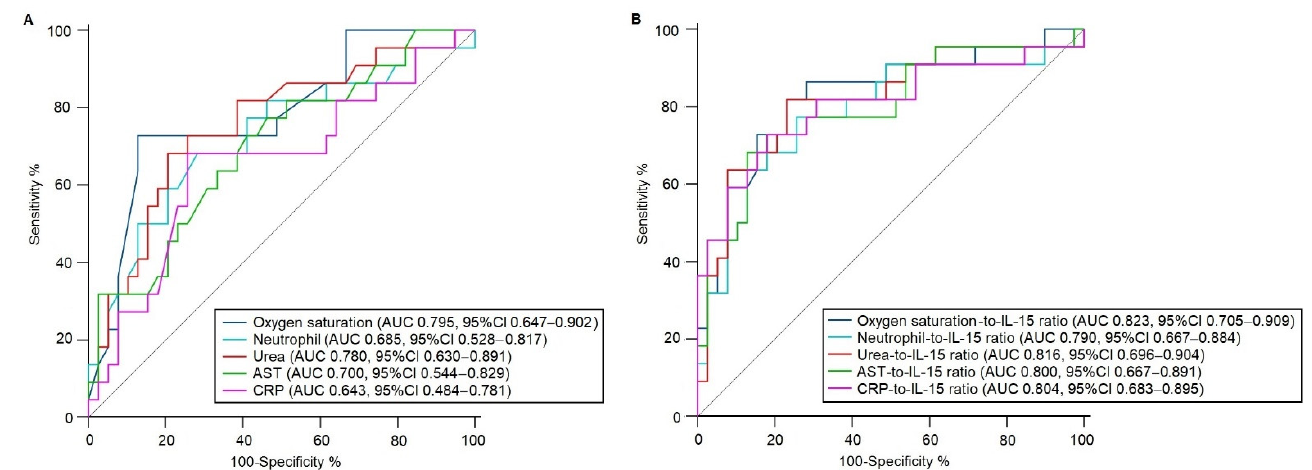
Figure 4. IL-15 serum values improved the area under the receiver operating characteristic curves of clinical and laboratory parameters. ( A ) AUROCs for oxygen saturation, the neutrophil count, blood urea, AST, and CRP. ( B ) AUROCs for the IL-15-to-oxygen saturation ratio, IL-15-to-neutrophil ratio, IL-15-to-urea ratio, IL-15-to-AST ratio, and IL-15-to-CRP ratio. We considered a p value < 0.05 as significant. AUROC, area under the receiver operating characteristic curves; AUC, area under the curve; CI, confidence interval; AST, aspartate aminotransferase; CRP, C-reactive protein.